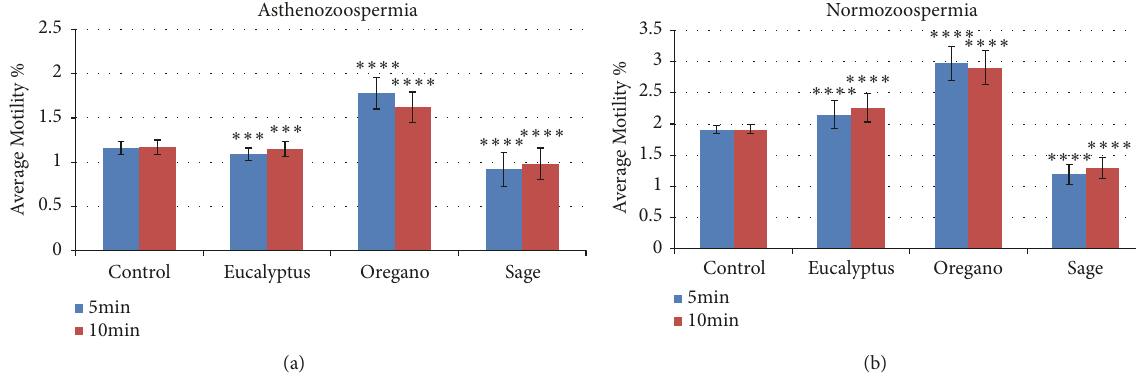
Figure 2: The in in vitro effect of EOs on the proportion of spermatozoa with fresh mobility ≥ 32%. The dilution of EOs was prepared in a solution of sterile agar at 0.2% (w / v) for a range of concentrations: 10 −1 , 10 −2 , 10 −3 , and 10 −9 . The motility percentage of each aliquot was measured immediately after the addition of the HE (t = 5 min) and 10 minutes later (t = 10 min). The data are expressed as mean ± standard deviation (n = 5). ( ∗ ) indicates “p” values: ∗ significant (p < 0.05); ∗∗ highly significant (p < 0.01); ∗ ∗ ∗ highly significant (p < 0.001).